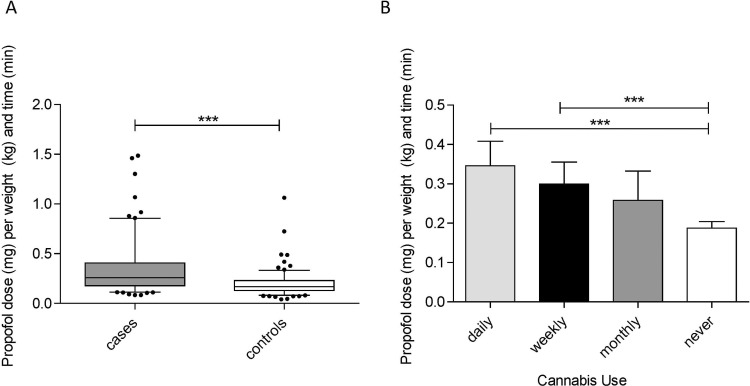
Mean propofol dose per unit of weight in kilograms and time in minutes for cases and controls (A) as well as sub-divided by frequency of cannabis use (B).Box plot outlines represent the 25th and 75th percentile values (A). Error bars (A and B) represent the 95% confidence interval. *p<0.05, **p<0.01, ***p<0.001.